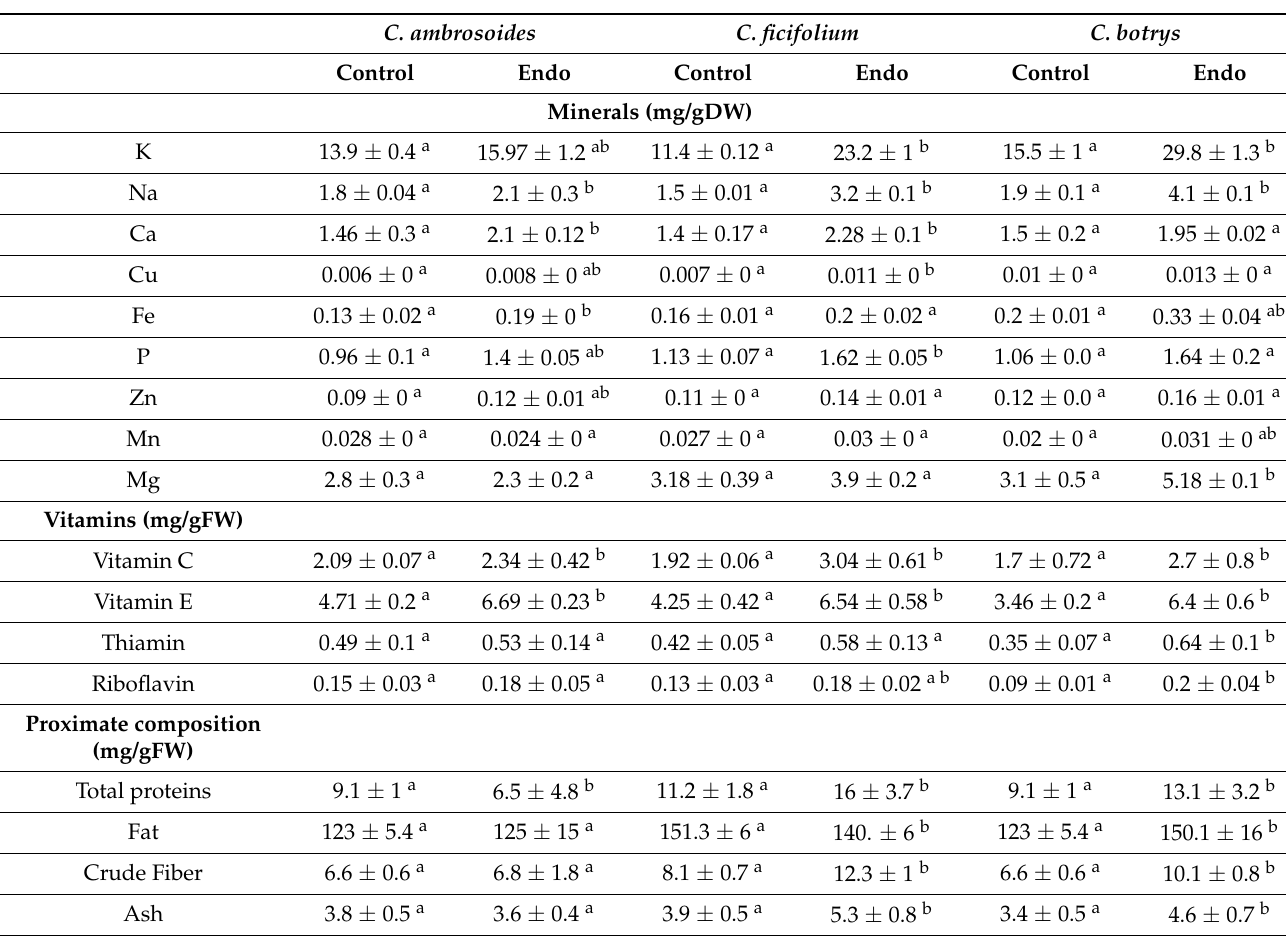
Table 3. Proximate composition, vitamins, minerals of control, and endophytic bacterial-treated Chenopodium ambrosoides, Chenopodium ficifolium, and Chenopodium botrys sprouts. Data are represented by the means of at least 3 replicates ± standard deviations. Different small letter superscripts (a, b) within a row indicate significant differences between control and endophytic bacterial